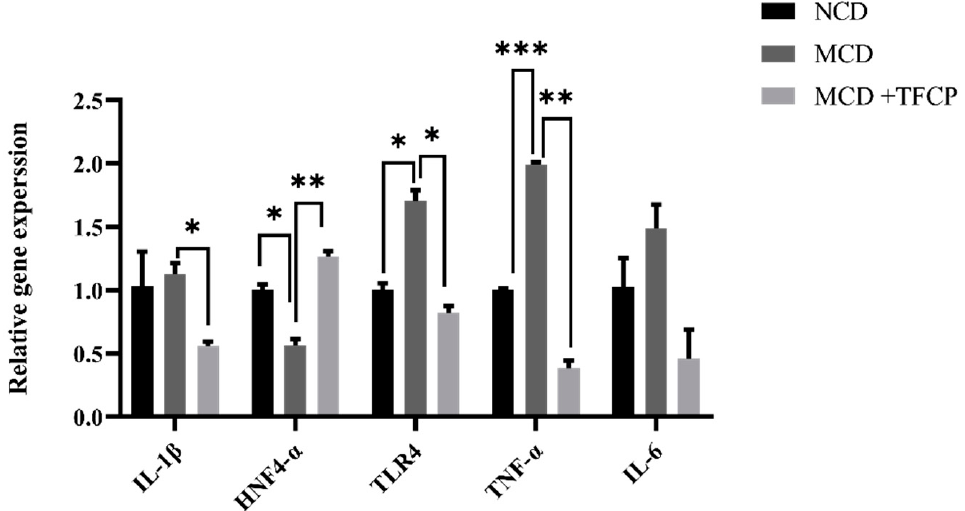
Figure 5. The TFCP-induced downregulation inflammation in MCD-fed mice. Mice were fed with MCD or the control diet for six weeks, while the intragastric administration of TFCP to MCD-fed mice was performed daily. The mRNA levels of IL-1 β , HNF4 α , TLR4, TNF- α , and IL-6 were measured by qPCR. The means ± SEM of the results in the graph were obtained using NCD ( n = 5), MCD diet-fed group ( n = 5), and MCD + TFCP ( n = 5). Data were shown as the mean ± SEM (*** p < 0.001; ** p < 0.01, * p < 0.05).